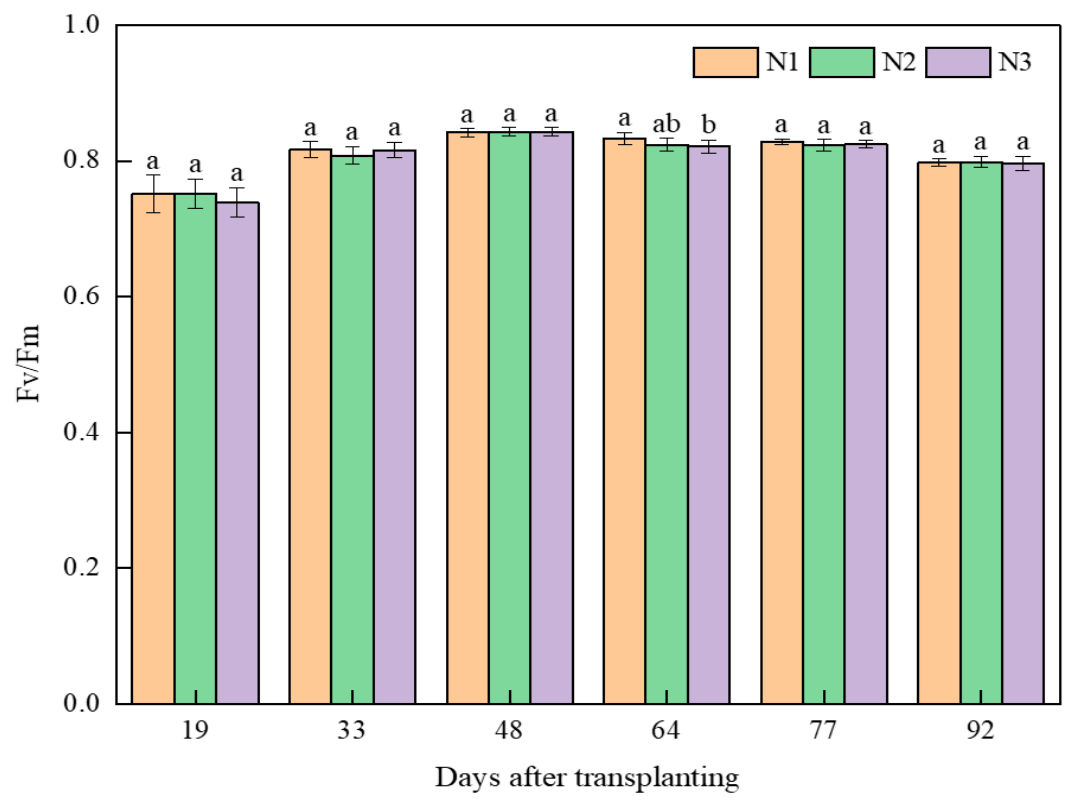
Figure 3. Trends of Fv/Fm with fertility under different fertilizer conditions. Different letter means the significance